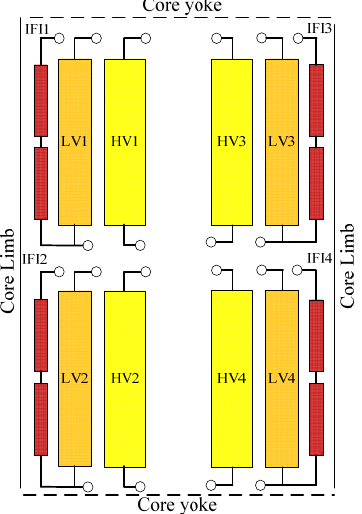
Figure 3. Structure of the harmonic suppression traction transformer (HSTT) with integrated filtering inductors (IFIs).